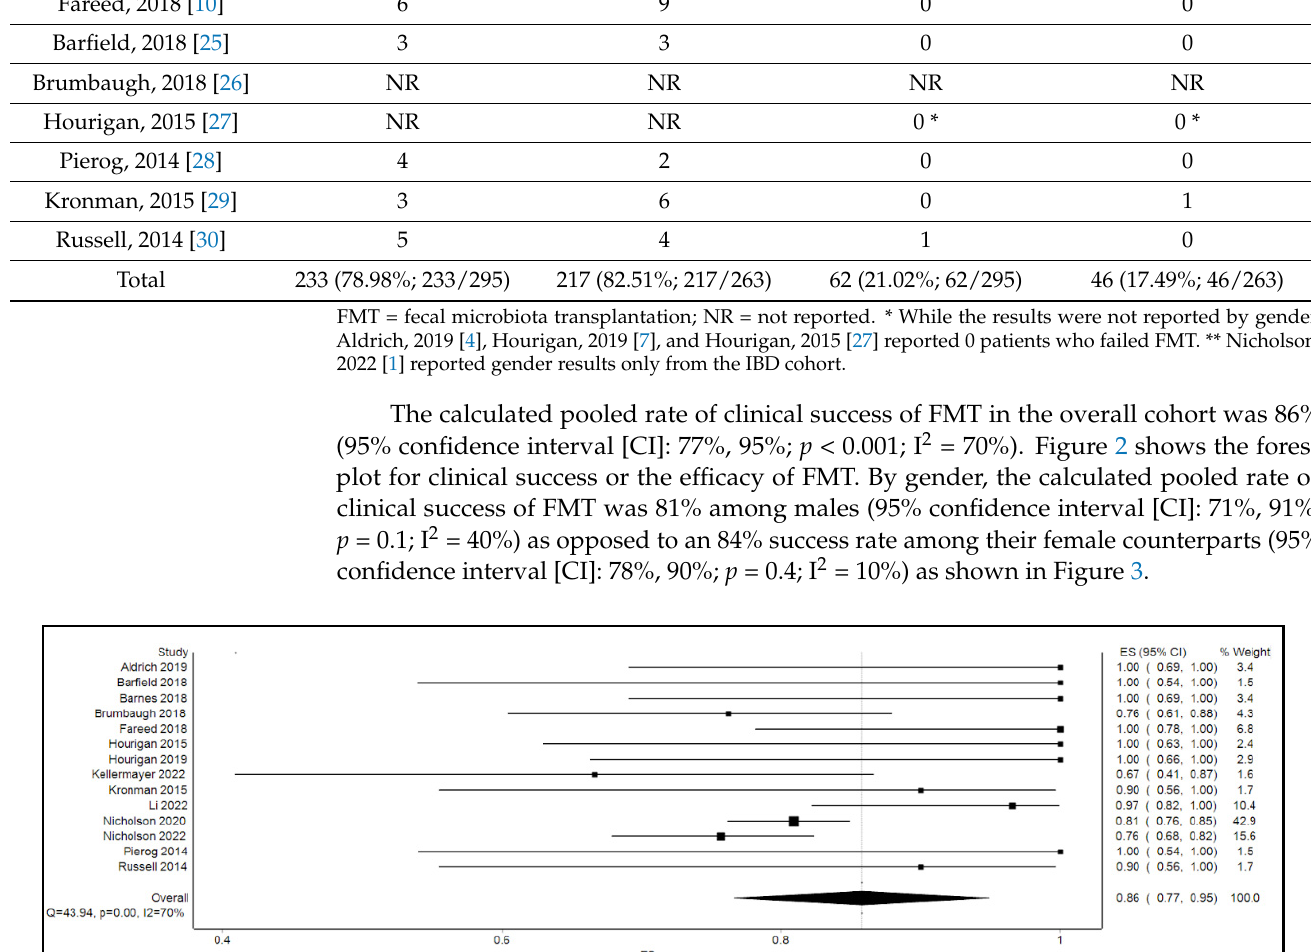
Figure 3. Forest plot displaying clinical efficacy of FMT by gender. Efficacy outcomes in the patients with IBD who received FMT are tabulated in Table 6. Li, 2022 [2] and Aldrich, 2019 [4] did not differentiate the results for IBD patients. In Aldrich, 2019 [4], it was noted that 14% of the 175 subjects had known or were later diag- nosed with IBD, the number of which was approximated to 25. In Nicholson, 2020 [5], out of the 120 IBD patients, only 111 had data available regarding FMT. In Barfield, 2018 [25], one patient required an additional delivery of FMT after 3 months from initial FMT due to the recurrence of symptoms and achieved resolution of CDI thereafter. In Brumbaugh, 2018 [26], one IBD patient required FMT twice for success while one patient still had per- sistent CDI despite also receiving FMT twice. In Russell, 2014 [30], one patient continued to experience gastrointestinal symptoms but remained negative on enzyme immunoassay (EIA) for CDI. The patient’s symptoms improved after initiating treatment for Crohn’s dis- ease. That patient was counted as a success. There was one patient who was lost to follow up after 2 months and was counted as a failure. The overall success rate of FMT for CDI in IBD patients was 75.33% (223/296) while the failure rate was 24.66% (73/296). Although the total number of patients in the IBD cohort was 337, since there were two studies that did